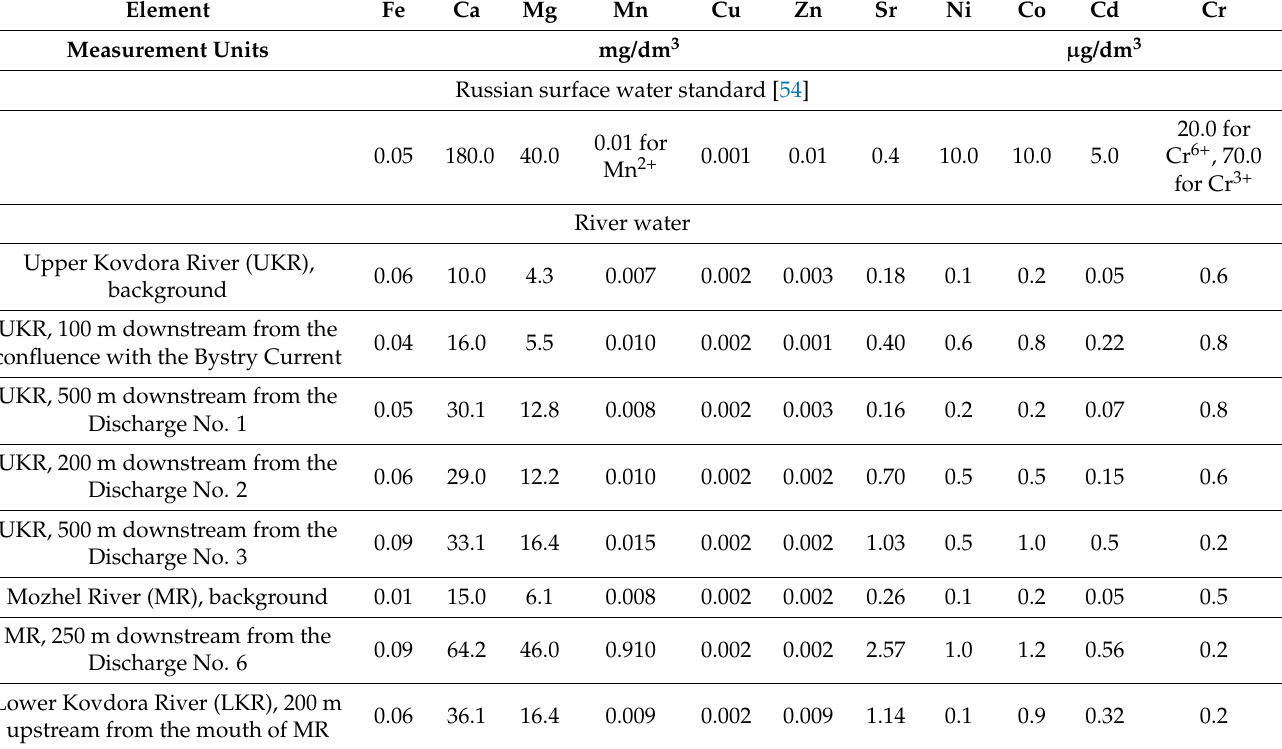
Table 3. Total metal content in the natural river water and the discharged